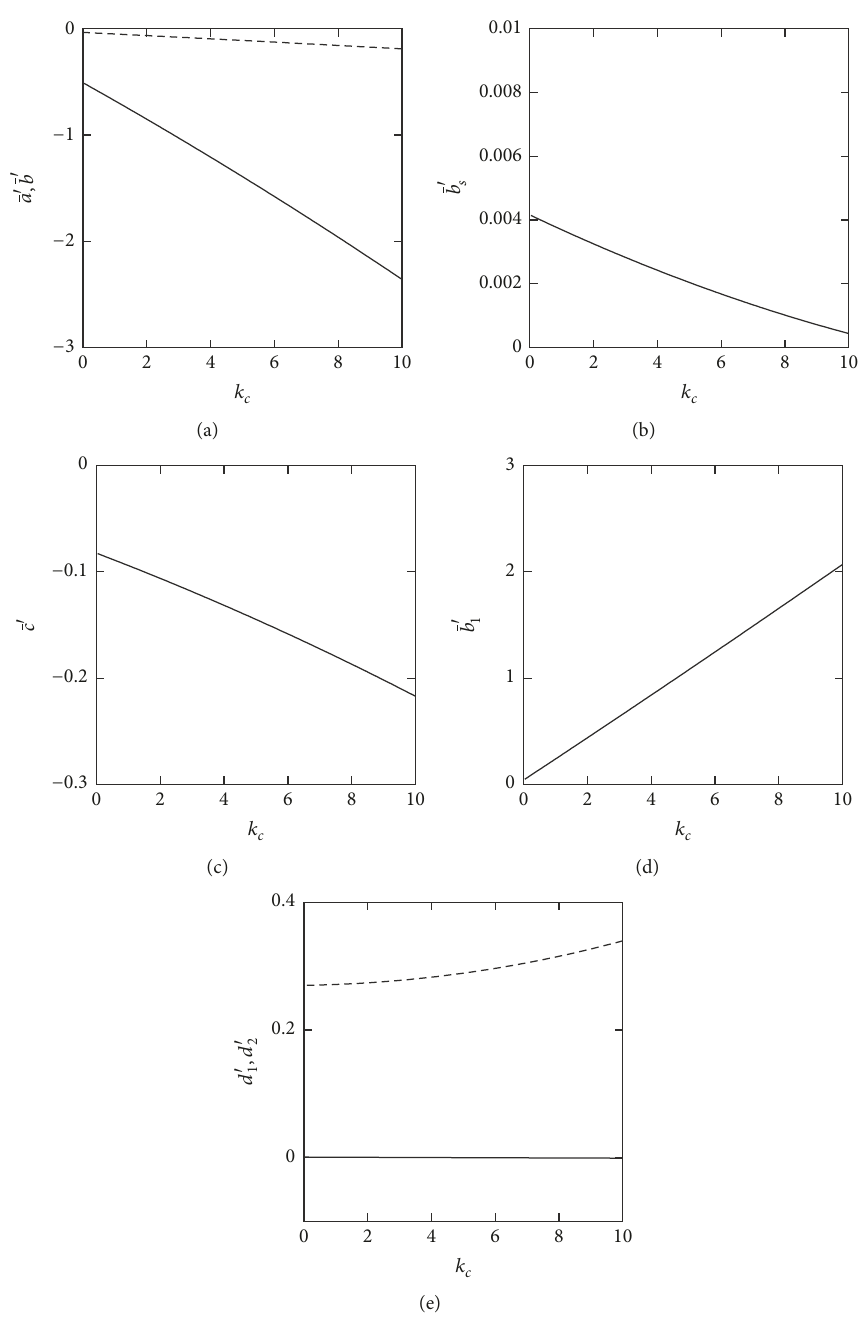
󸀠 󸀠 𝑐 󸀠 , 𝑏 󸀠 𝑑 󸀠 𝑑 󸀠 𝑘 𝛼 = 5.0 and 𝑊 = 1.0 . All the parameters in the vertical axis are scaled by 𝑅 2 , 𝑏 𝑐 . 𝑠 , 1 , 1 , and 2 on 󸀠 , respectively. (b) 𝑏